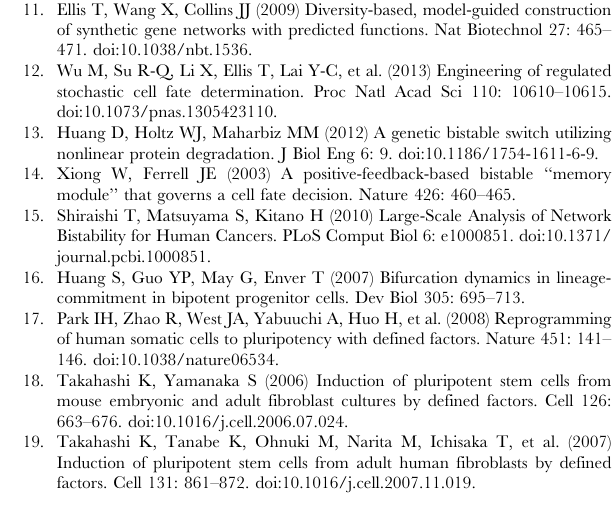
emphasize differences in y-locations of each SSS. Three planes drawn at y =0.1, 1, and 5. Two gray points and three red points lie on the bottom plane, four red points lie on the middle plane, the SSS from the orange and blue lines overlap due to our projection, and two gray points lie on the top plane. (D) Bifurcation diagram drawn with another different angle to emphasize differences in x- locations of each SSS. Three planes drawn at x= 0.1, 1, and 5. Two gray points lie on the left plane, four red points lie on the middle plane, with two overlapping, and two gray and two red points lie on the right plane. Figure S5 Bifurcation diagram in Figure 7B shown with different viewing angles and visual assistance. (A) The bifurcation diagram of Figure7B is illustrated again to provide a frame of reference; the figure legend is consistent among all subfigures. (B) Bifurcation diagram is shown from the same angle as in A with planes drawn at a = 1 and a = 5 where the red and gray points lie precisely on the plane. (C) Bifurcation diagram drawn with a different angle to emphasize differences in y-locations of each SSS. Three planes drawn at y = 0.1, 1, and 5. One gray point and one red point lie on the bottom plane, two red points exist between the lower and middle planes (approximately 0.3), two red points lie on the middle plane, and one gray point lies on the top plane. (D) Bifurcation diagram drawn with another different angle to emphasize differences in x-locations of each SSS. Three planes drawn at x= 0.1, 1, and 5. One gray point lies on the left plane, two red points lie on the middle plane, two red points exist between the middle and right planes and one gray point and one red point lie on the right plane. Figure S6 Visual representation of constrained steady state sub- space under noise perturbations. (A) Trajectory clouds displayed in Figures 3C are approximated by 3D ellipsoids. The radius in each dimension is correlated with the inverse of the strength of the eigenvalue corresponding to a particular eigenvector. i.e. if the eigenvalue for an eigenvector is only weakly negative, then the cloud will be large in the direction of that eigenvector. Here the all-OFF cloud is scaled down in size manually so that it fits on the graph. The all-OFF and all-ON states are both disk-shaped, with their primary eigenvalue being significantly stronger and facing [1,1,1]. (B) Similarly, 3D ellipsoids were used to visualize possible